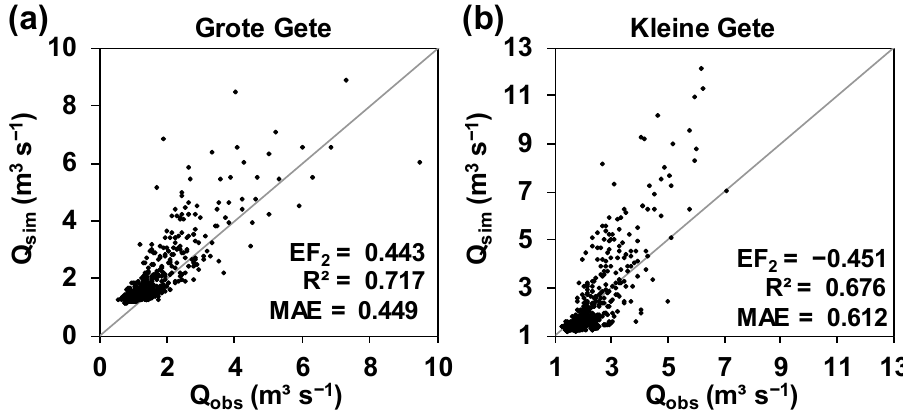
Figure 5. Multi-site (MS) scatter plots for the validation period [1 January 1987–31 December 1988] of observed (Q obs ) and SHETRAN predicted (Q sim ) total streamflow at the non-calibrated stations ( a ) Grote Gete; and ( b ) Kleine Gete (Figure 3d). EF 2 = Coefficient of Efficiency (Nash and Sutcliffe Efficiency); R 2 = square of the Pearson’s type (linear) correlation coefficient; MAE = Mean Absolute Error.